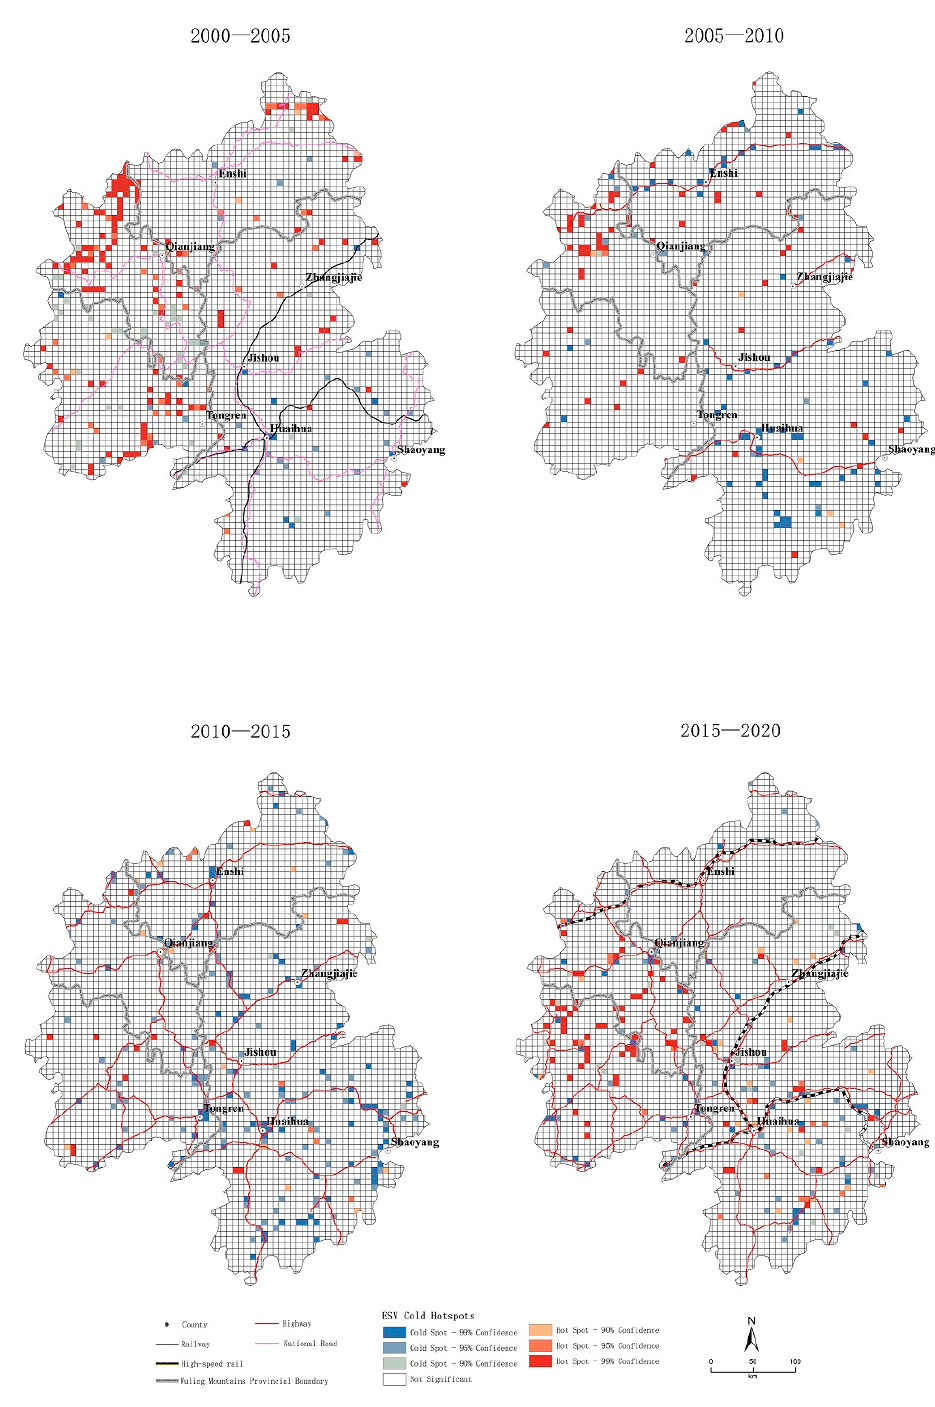
Figure 8. Hot-spot analysis of ESV Figure 8. Hot ‐ spot analysis of ESV changes.